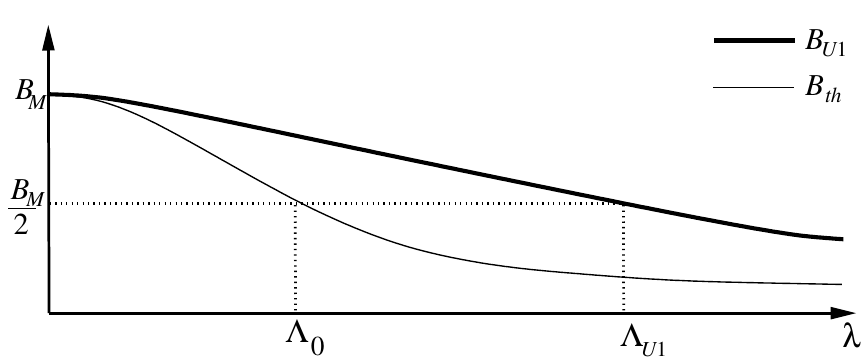
Figure 13. Suppression of the Unruh vacuum decay far from the BH as a function of the BH temperature T = λ/ (2 π ) (thick line). The transition between the low-temperature bounces BH and the high-temperature stochastic jumps happens at Λ , see eq. (5.25). Thin line shows for U 1 comparison the suppression of false vacuum decay in a thermal bath with the same